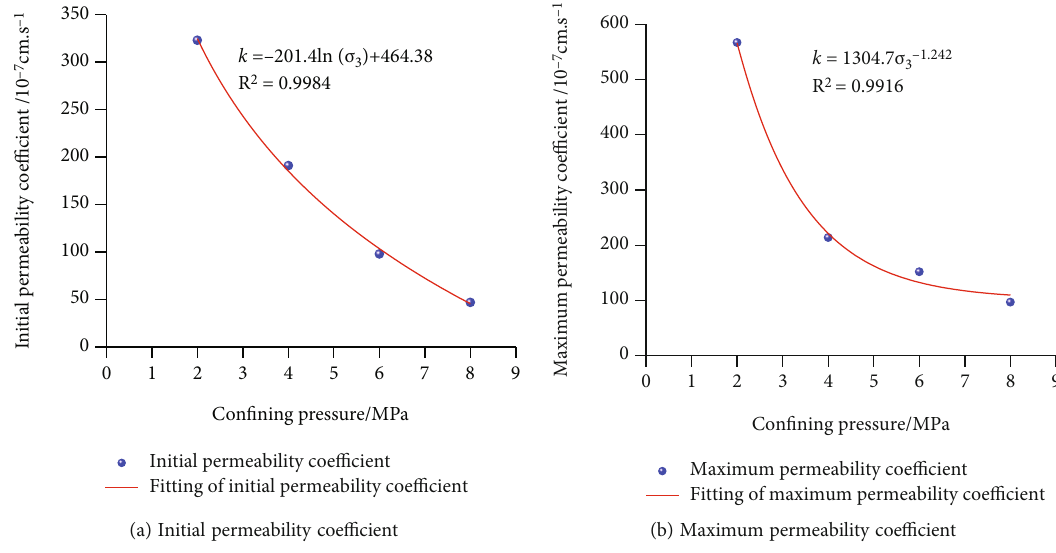
Figure 5: The relationship between permeability coe ffi cient and con fi ning